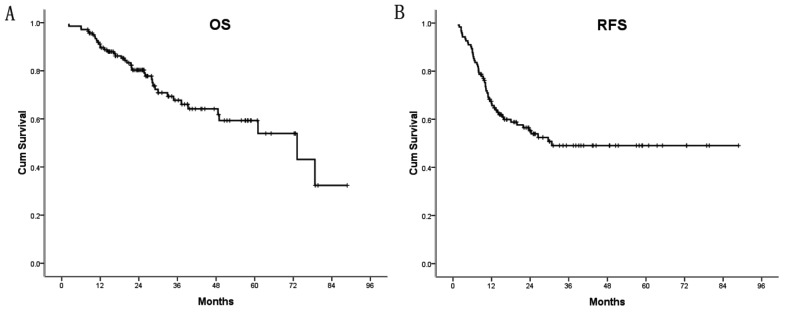
Kaplan–Meier curves for overall survival (a) and recurrence free survival (b) after CRLM resection for the entire patient cohort.The median OS for all patients was 73.2 months, and the proportion of patients alive at 3 and 5 years was 65% and 53%, respectively. The median RFS period was 30.7 months.